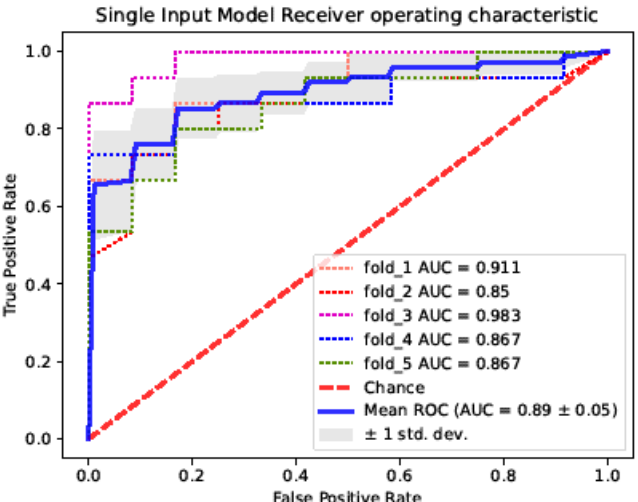
Figure 7. ROC curve of the single-image input processing network collateral circulation evaluation model.